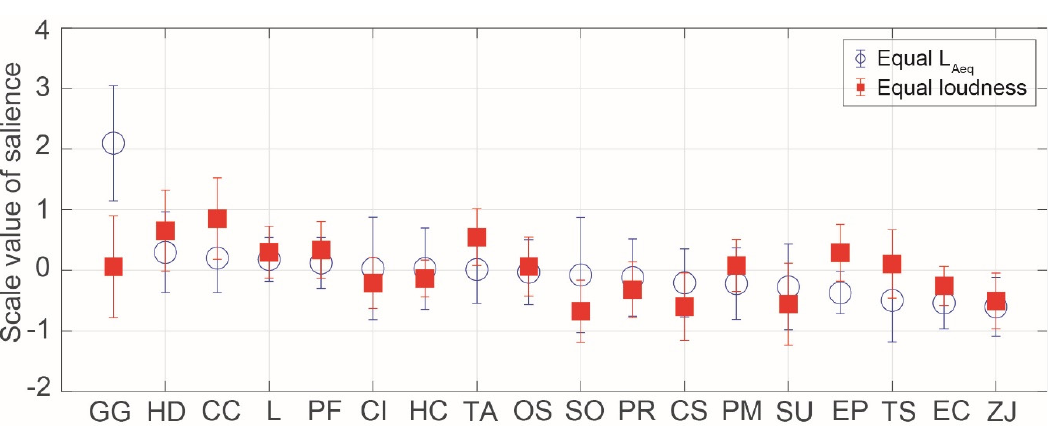
Figure 5. Scale values of saliences for birdsongs in the equal L Aeq and loudness conditions. The symbols indicate the mean values and the error bars indicate standard deviations.